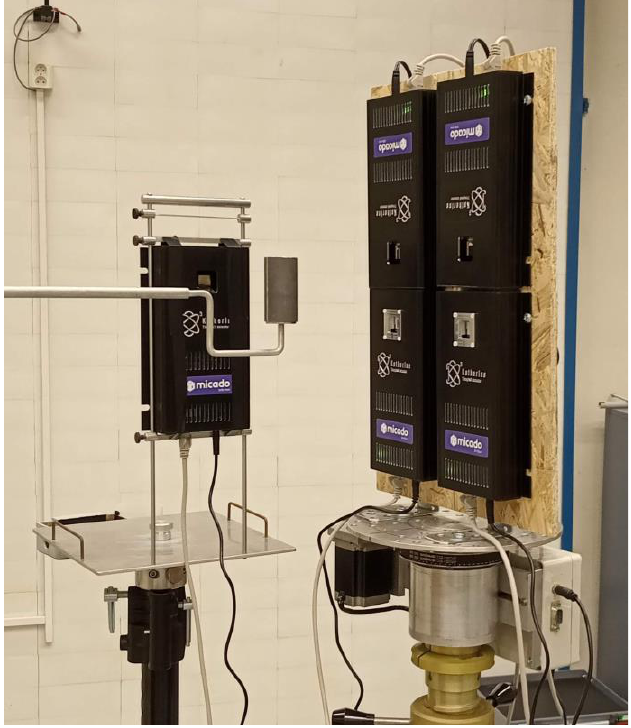
Fig. 3. Fast neutron calibration setup with an 241 AmBe source and five detectors operated